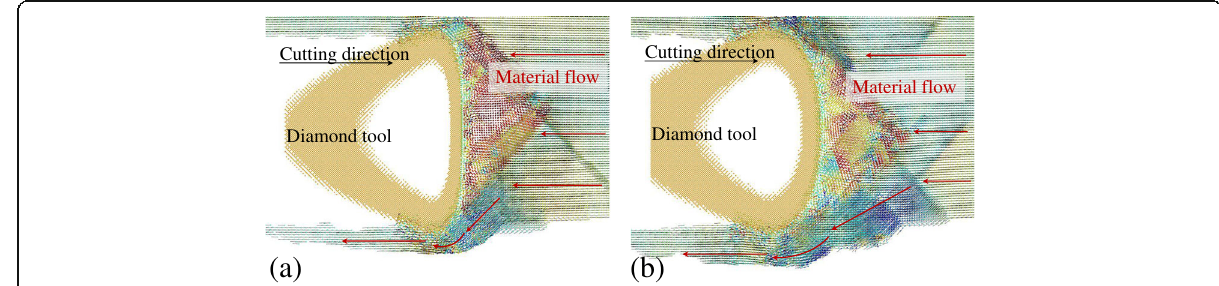
Fig. 11 Displacement vector plots at tool edge radius of ( a ) 2.5 nm and ( b ) 5 nm in cutting direction of {100} <